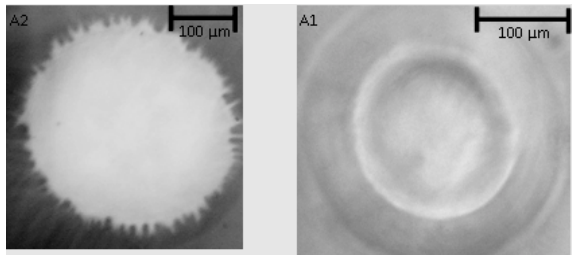
Figure 6. Microscopic view of core–clad interface of two fiber preform samples: A1 and A2 .